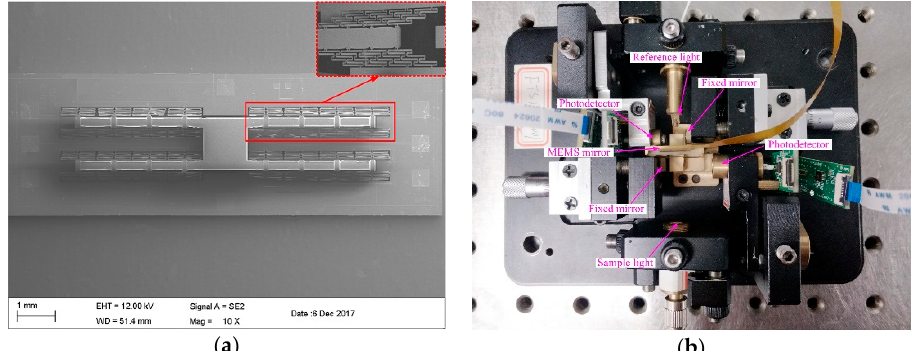
Figure 33. The scan stability H-shaped electrothermal MEMS based FTS: ( a ) MEMS mirror; ( b ) FTS system. (Reprinted with permission from Reference [9] IOP Publishing, Ltd.).